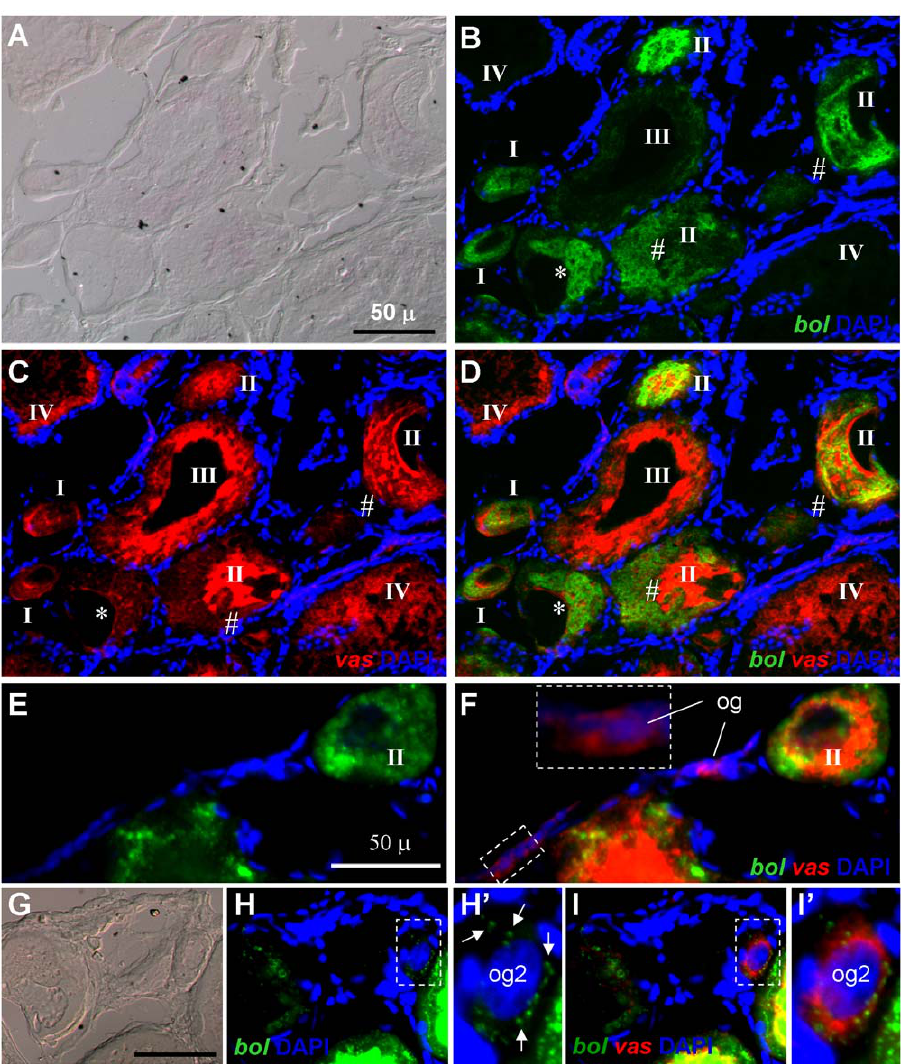
Figure 6. Expression of boule and vasa transcripts in trout oogenesis. Adult ovarian cryosections were hybridized to antisense RNA probes and the signals were visualized by fluorescence staining. Nuclei were stained blue by DAPI. (A–D) Stages I–IV of oocytes. Oocytes showing co- distribution (*) and alternative distribution ( # ) are indicated. (E and F) Oogonia. (G–I’) Differentiating oogonium entering into meiosis, highlighting the onset of boule RNA expression at this stage. (H’ and I’) Larger magnifications of framed areas in (H and I). This oogonium retains nuclear staining by DAPI and contains a few speckles of boule RNA (arrows). Scale bars, 50 m m.